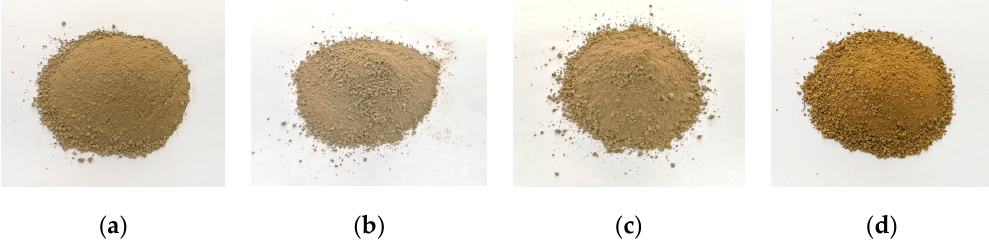
Figure 3. Soil samples in air-dried state. ( a ) Yangling, Shaanxi; ( b ) Yangxian, Shaanxi; ( c ) Huining, Gansu; ( d ) Jingning, Gansu.